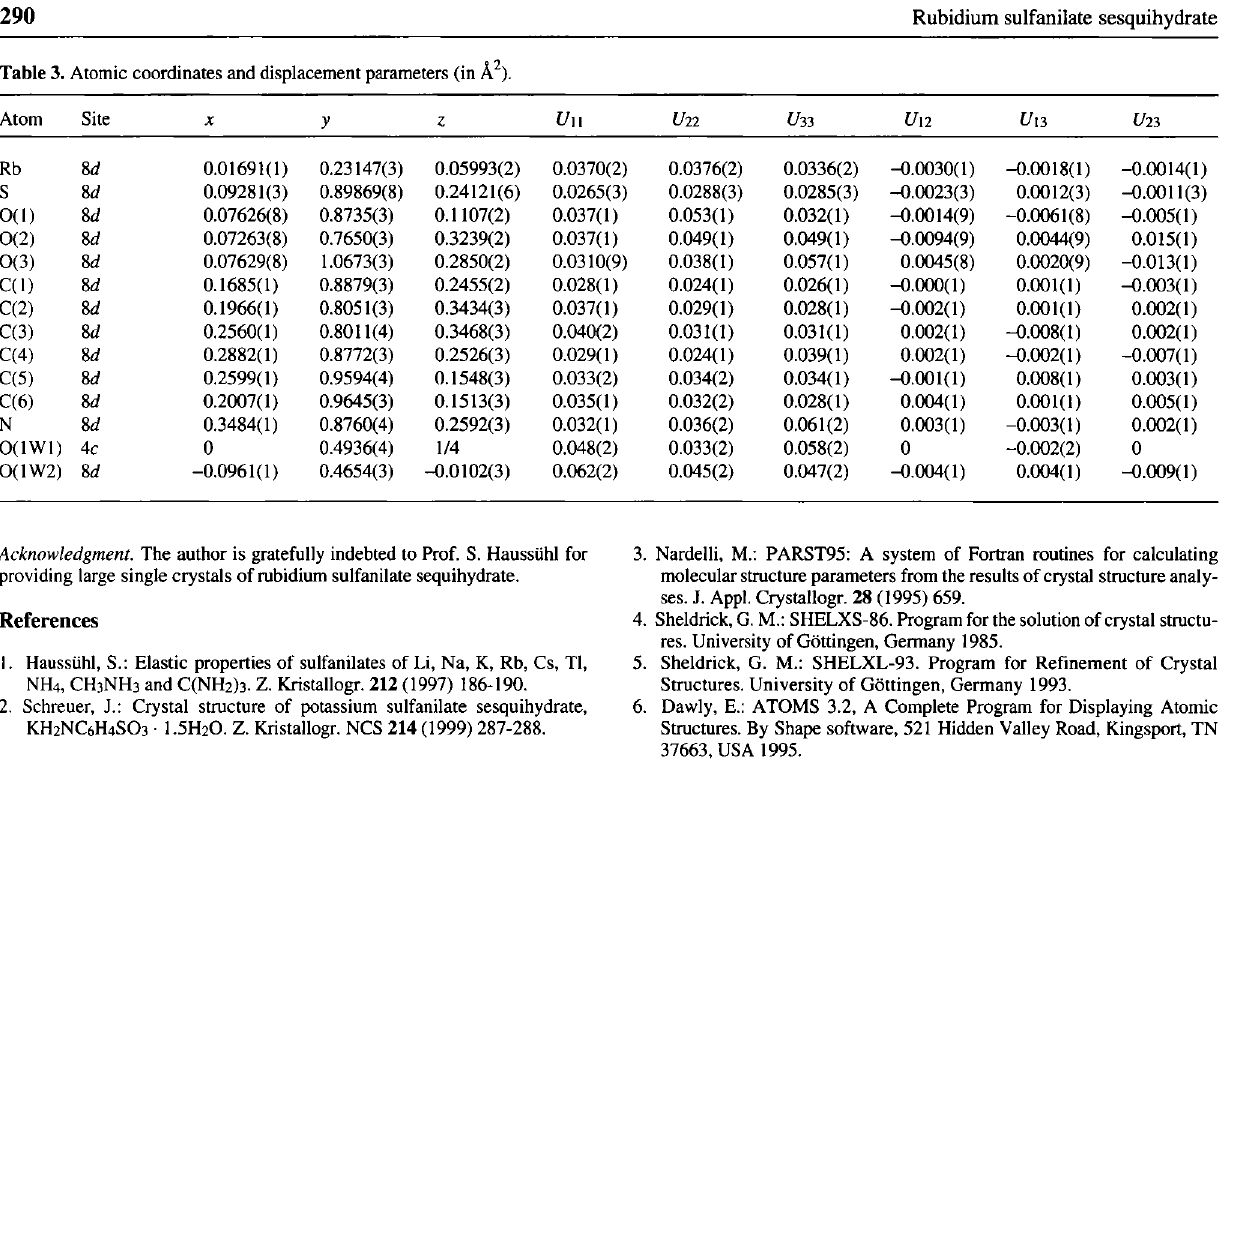
Table 3. Atomic coordinates and displacement parameters (in Ä 2